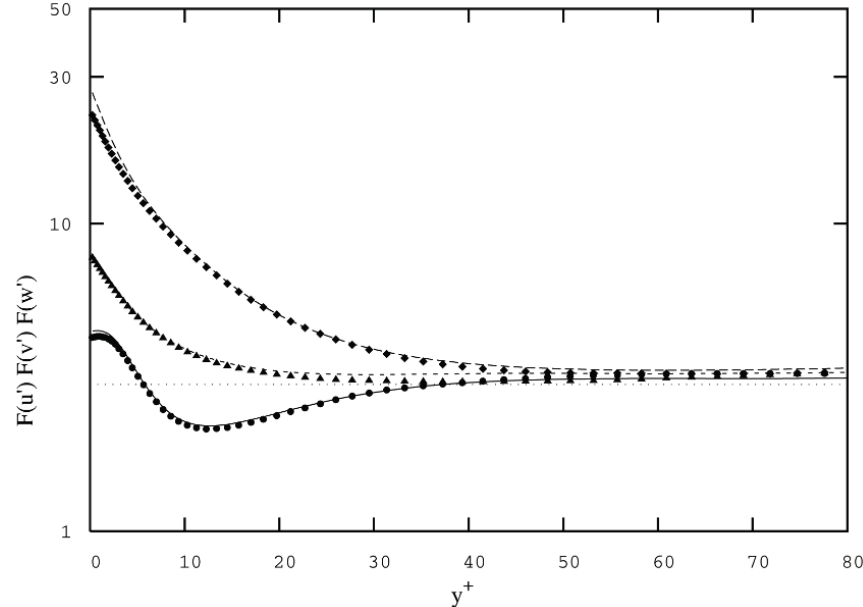
Figure 7. Computational test-case. Skewness factors of the velocity fluctuations; reference solver, ( ●● ) Flow-3D solver; S : (– – ) reference solver, ( ▲▲ ) Flow-3D solver. ′ w